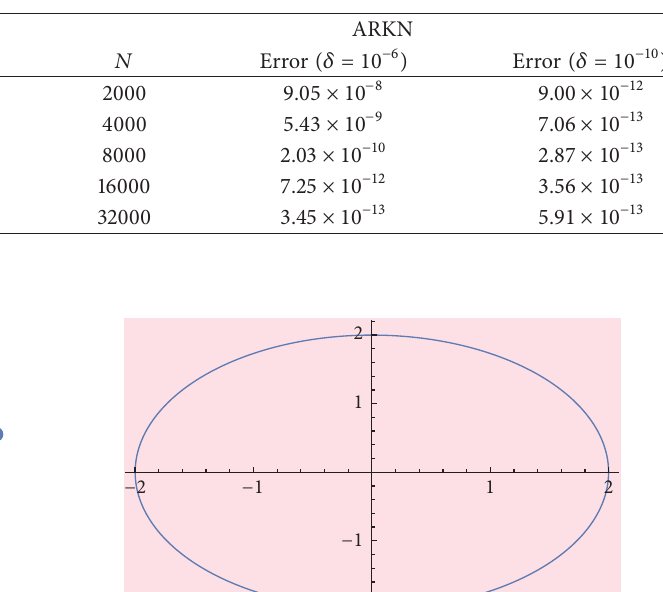
Table 4: Results for Example 5.